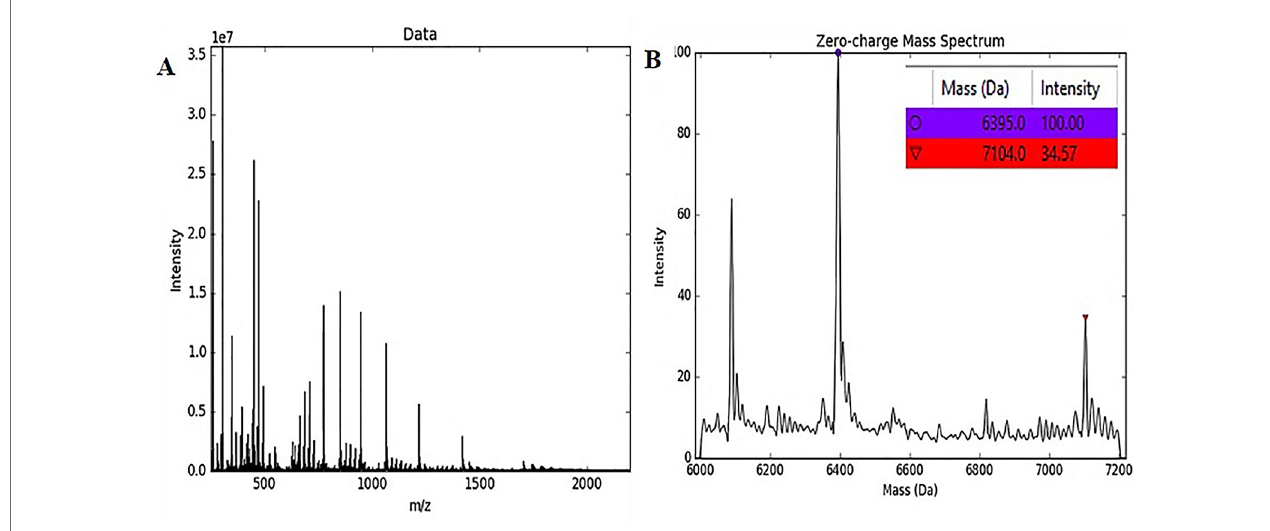
FIgUrE 7 | MS spectra and molecular weight of native protein. (A) The spectrum obtained by MS of the SCI-57 purified fractions (A2–A7) containing SCI-57 in its native form. (B) Molecular weight of proteins contained in SCI-57 purified fractions, by applying the deconvolution to the spectrum obtained by MS.